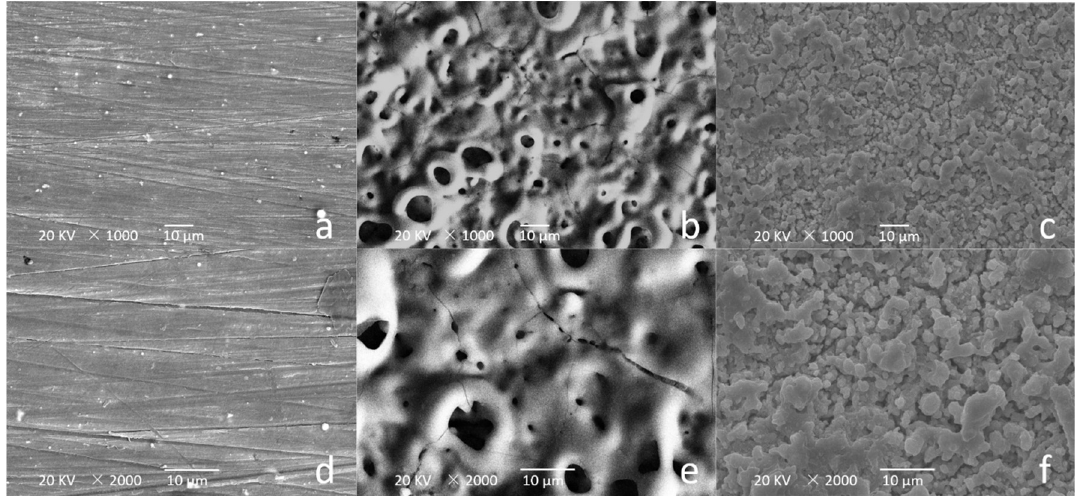
Figure 1. Scanning electron microscopy (SEM) images of ( a , d ) AZ31, ( b , e ) micro-arc oxide (MAO) + AZ31, and ( c , f ) aminated hydroxyethyl cellulose (AHEC) + MAO + AZ31.